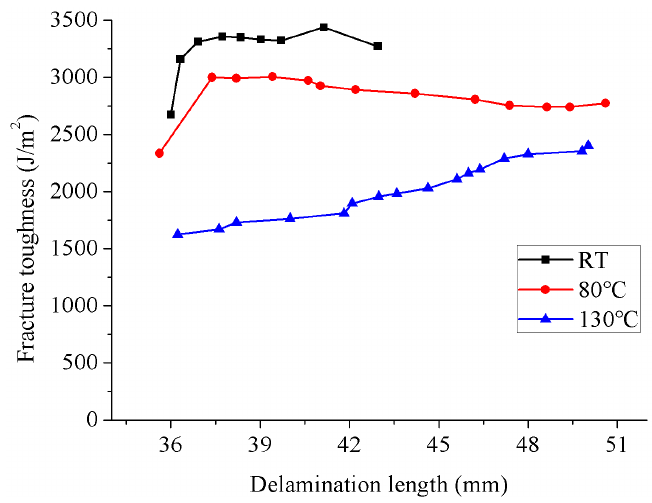
Figure 6. R -curves of ENF specimens evaluated at different temperatures.